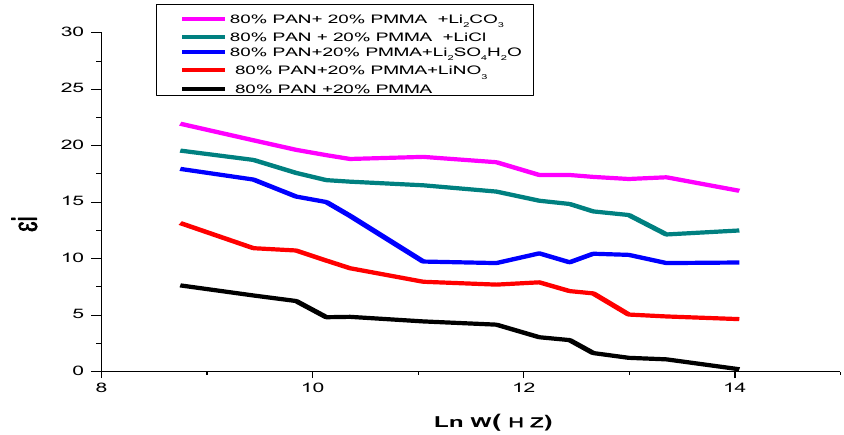
Figure 3a: The Imaginary dielectric constant as function of ln (ω) of undoped (80%PAN+20%PMMA) and doped with 20% (LiNO